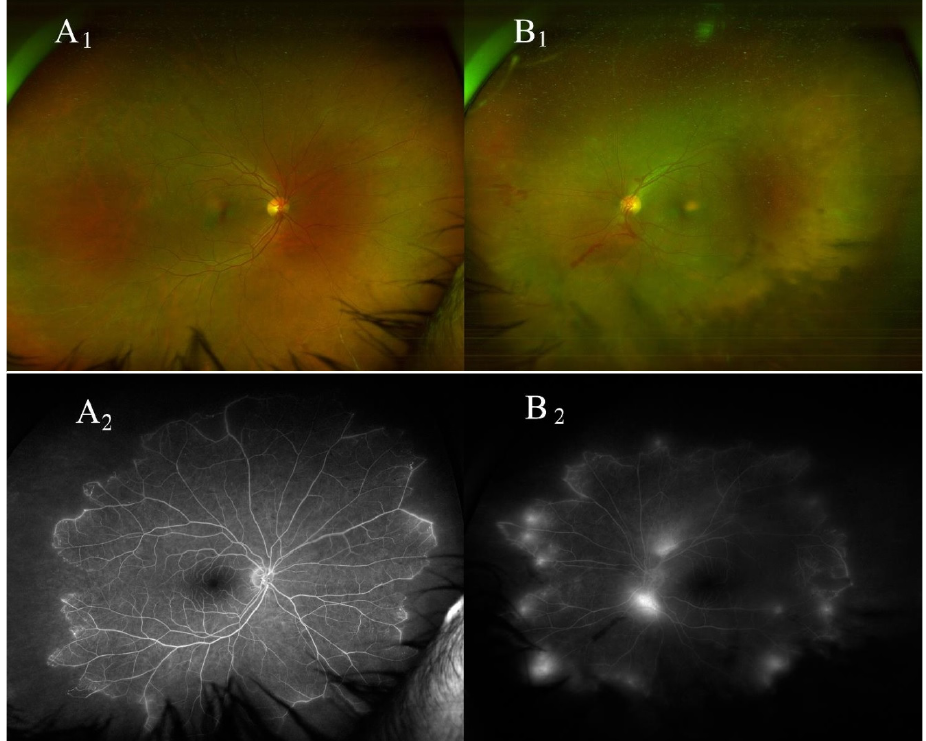
Figure 1. In the right eye, fundus imaging ( A1 ) shows peripheral periphlebitis, and wide field fundus fluorescein angiography ( A2 ) shows staining of peripheral vessels as well as areas of retinal capillary nonperfusion with 360 ‐ degree peripheral ischemic areas. In the left eye, fundus imaging ( B1 ) shows vitreous hemorrhages as well as retinal neovascularization at the disk area, and in the peripheral retina, wide field fundus fluorescein angiography ( B2 ) shows areas of retinal capillary nonperfusion with 360 ‐ degree peripheral ischemic areas as well as areas of leakage from retinal